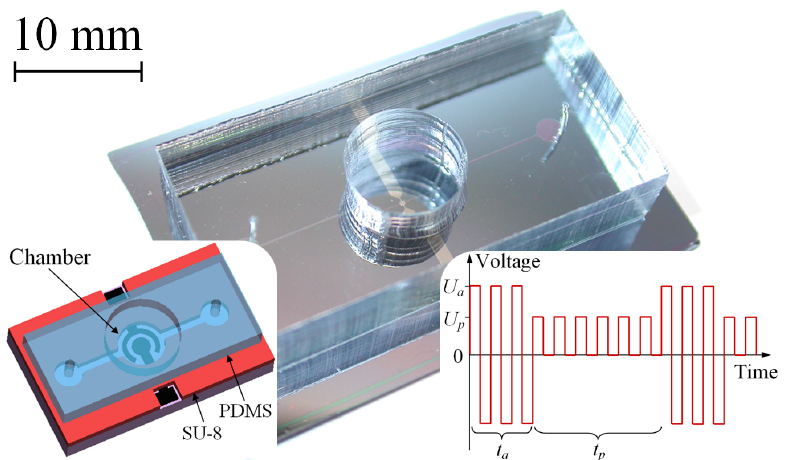
Figure 1. A photo of the fast electrochemical actuator. The left-hand inset shows a schematic view of the device, while the right-hand one demonstrates the driving signal applied to the actuator in the new working